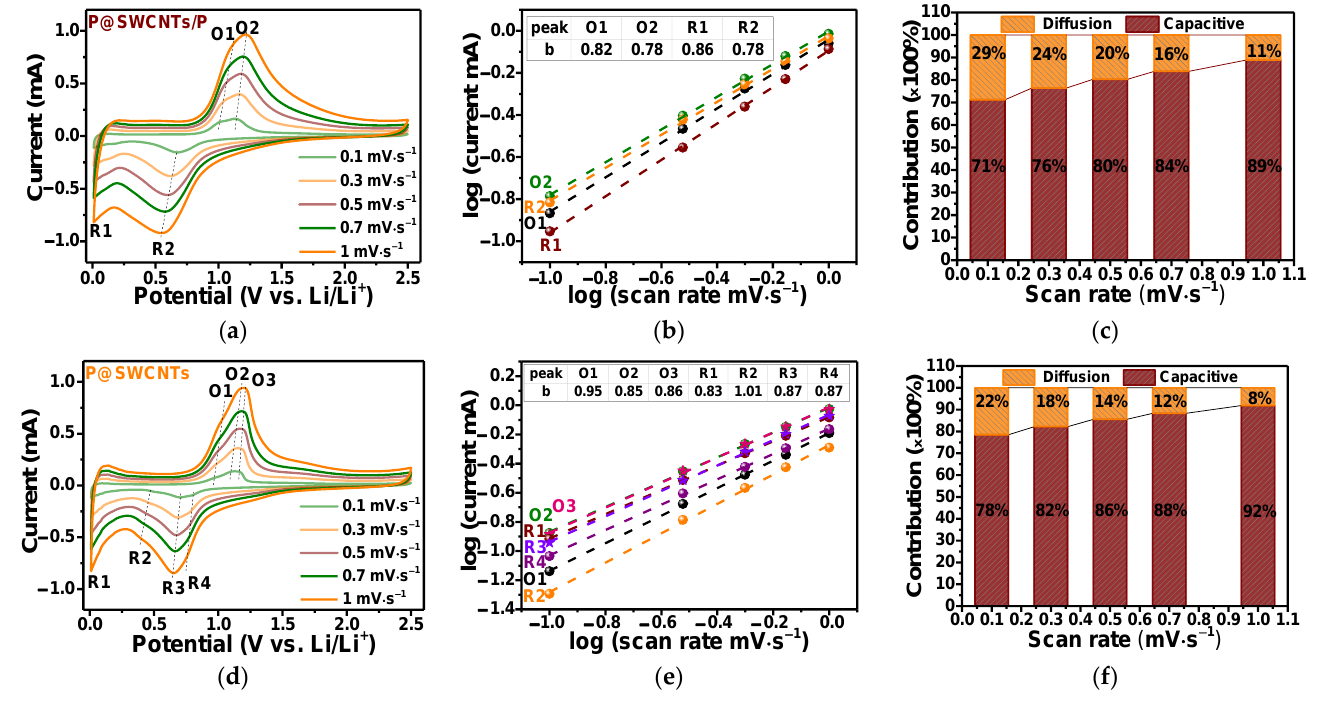
Figure 8. CV curves of ( a ) P@SWCNTs/P and ( d ) P@SWCNTs nanomaterials at different scan rates; log( i ) vs. log( v ) plots for selected peaks of ( b ) P@SWCNTs/P and ( e ) P@SWCNTs; the normalized ratio of capacitive and diffusion-controlled contributions at different scan rates of ( c ) P@SWCNTs/P and ( f ) P@SWCNTs.